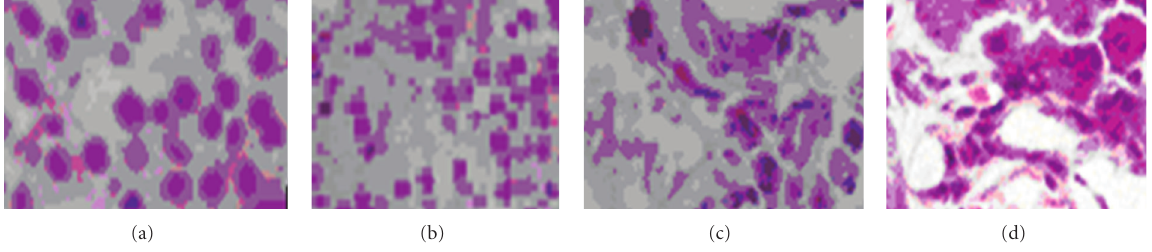
Figure 4: Islet cell death and replication represented by hematoxylin-eosin.